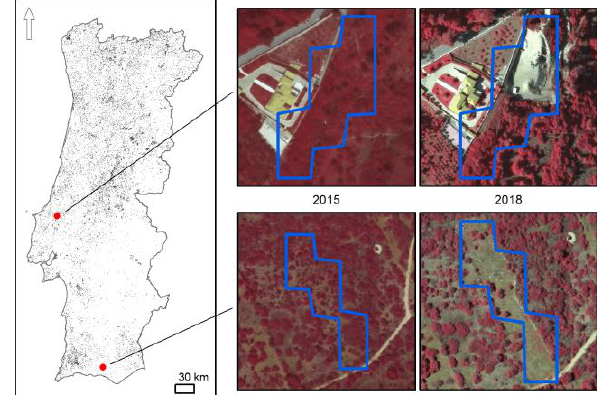
Figure 6. Alerts produced for vegetation loss in forest and shrubland. Two examples of change between 2015 and 2018 are shown for central and south